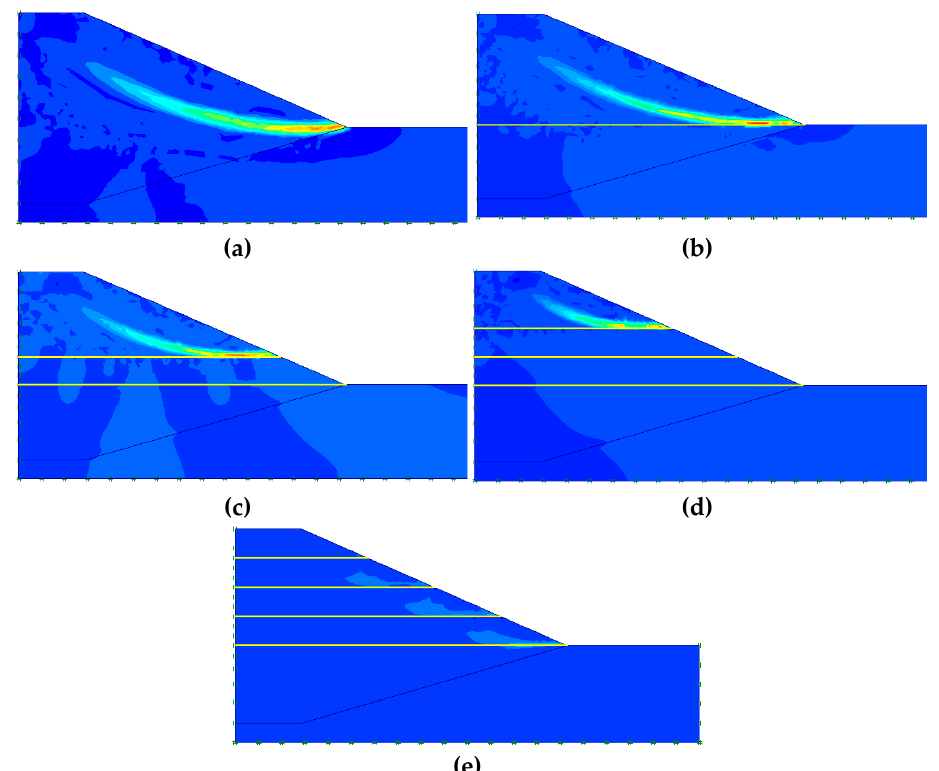
Figure 11. ( a ) Shear strain increment (without geogrids); ( b ) shear strain increment with one geogrid; ( c ) shear strain increment with two geogrids; ( d ) shear strain increment with three geogrids; ( e ) shear strain increment with four geogrids. Shear strain increment in FEM analysis.